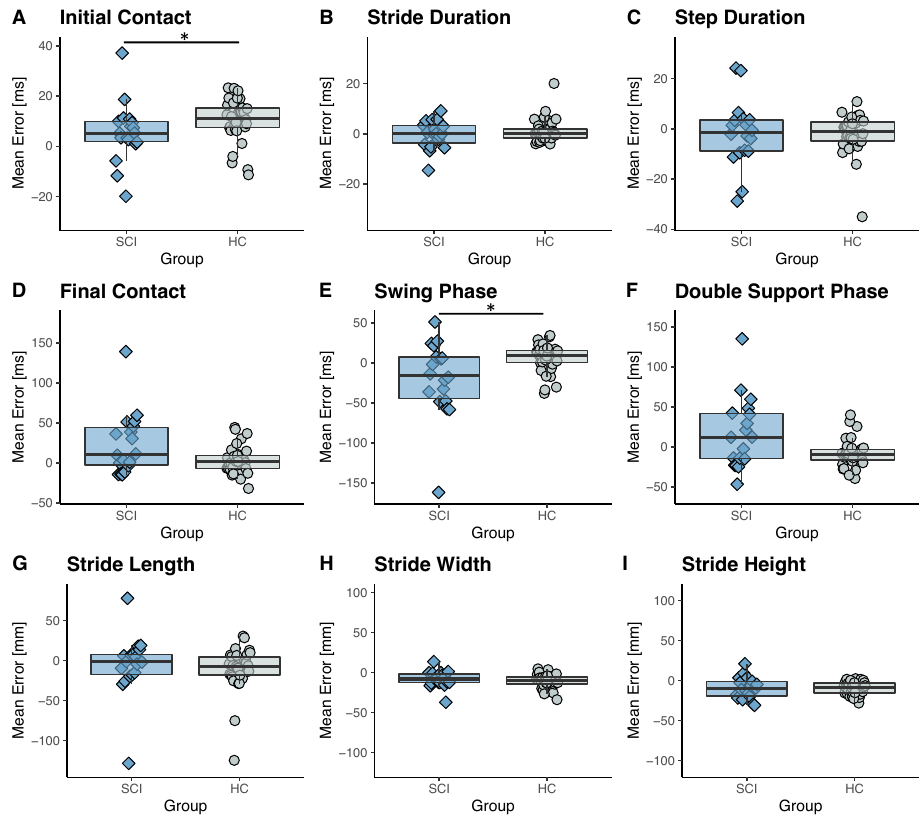
Figure 4. Mean error between the ground truth and sensor-derived gait parameters for the SCI patients and healthy controls (HC) walking on a treadmill at 0.5 m/s are shown. Boxes indicate 1st to 3rd quartile and the whiskers extend from the hinges to the largest/smallest value within 1.5 interquartile range. The black bar in the boxes displays the median. Significant differences between the two cohorts are indicated by * ( p <